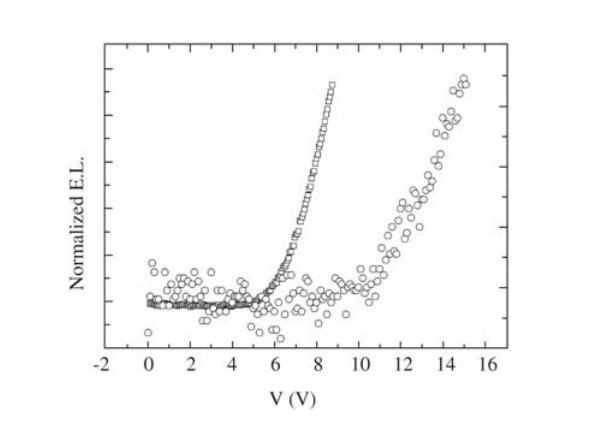
Figure 4. Electroluminescent intensity (EL) as a function of bias voltage (V) of a FTO/PEDOT:PSS (50 nm)/OPPVDBC (20 nm)/ Ca/Al device (circles) and of a FTO/PEDOT:PSS (50 nm)/ (45 nm)/Ca/Al device (squares); R. OPPVDBC (45 nm)/Alq 3 Lessmann et al.